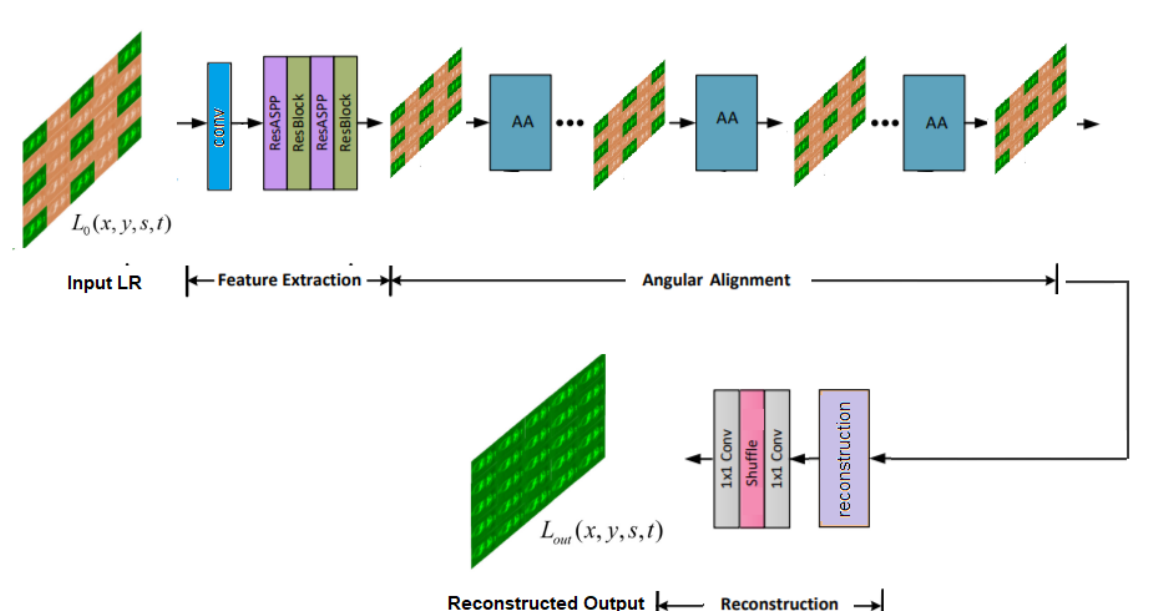
Figure 1. An overview of the proposed lightweight deformable deep learning